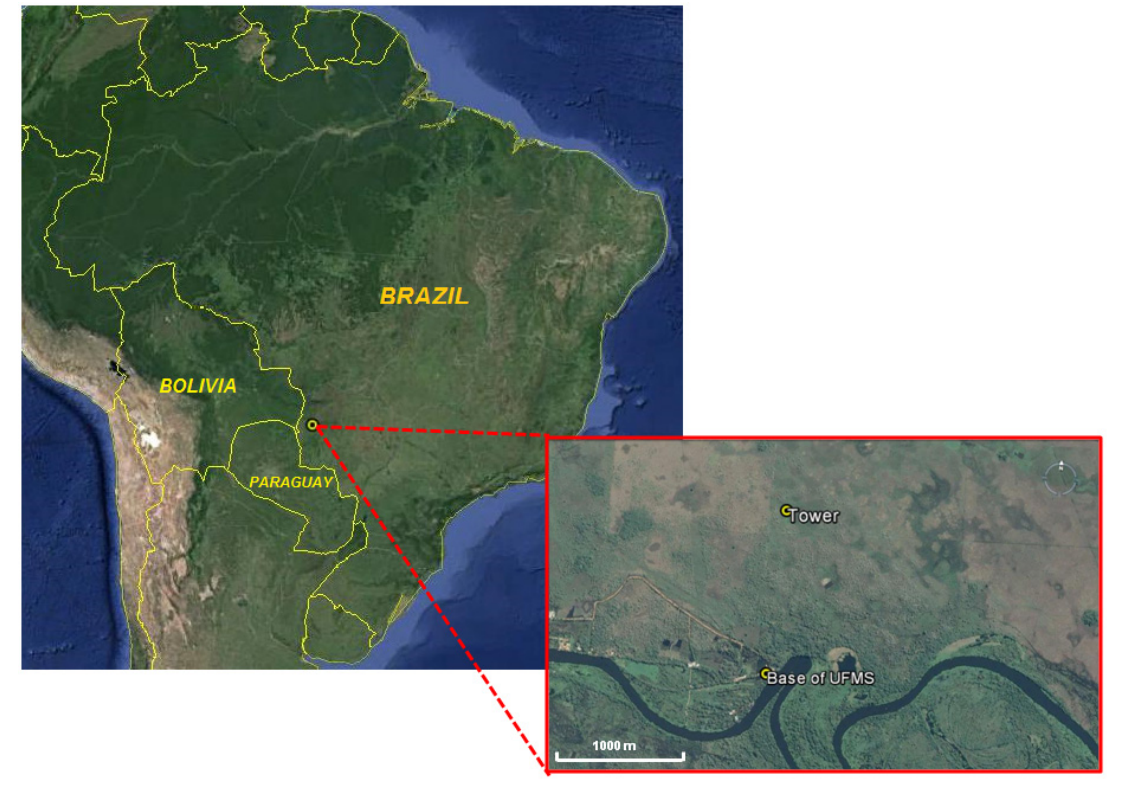
Figure 1. Map of the experimental site.